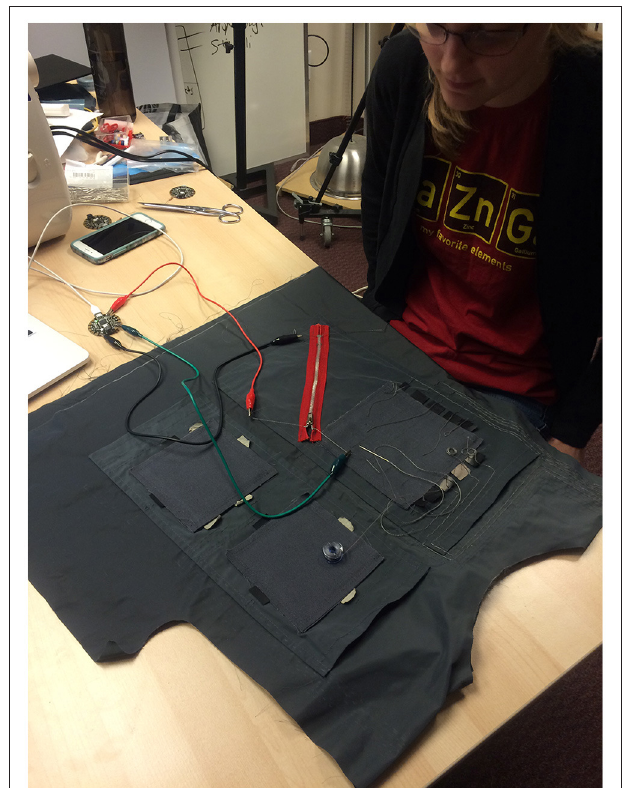
FIGURE 4 | Placement of the sensors on the initial vest prototype (X/Y Pad, X/Y/Z Pad, zipper, and 5 × 5